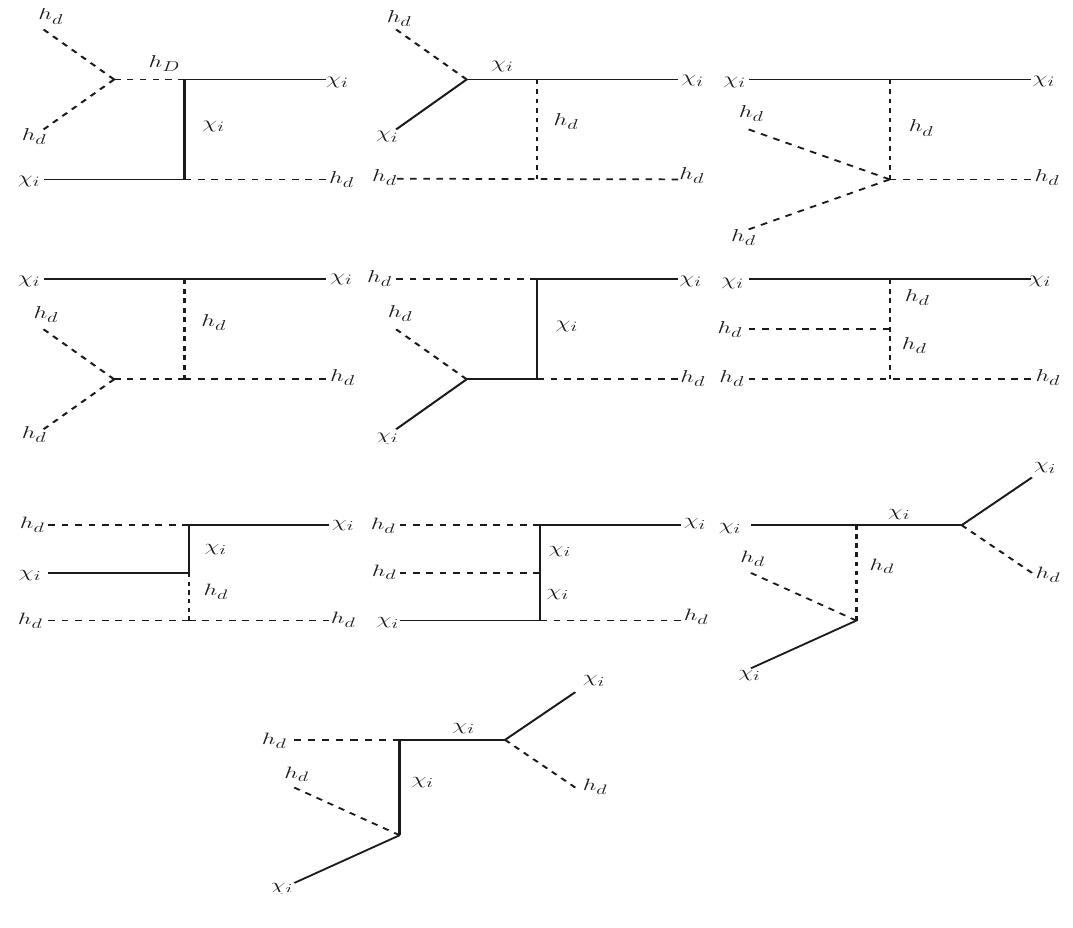
h d h d → χ h d i i